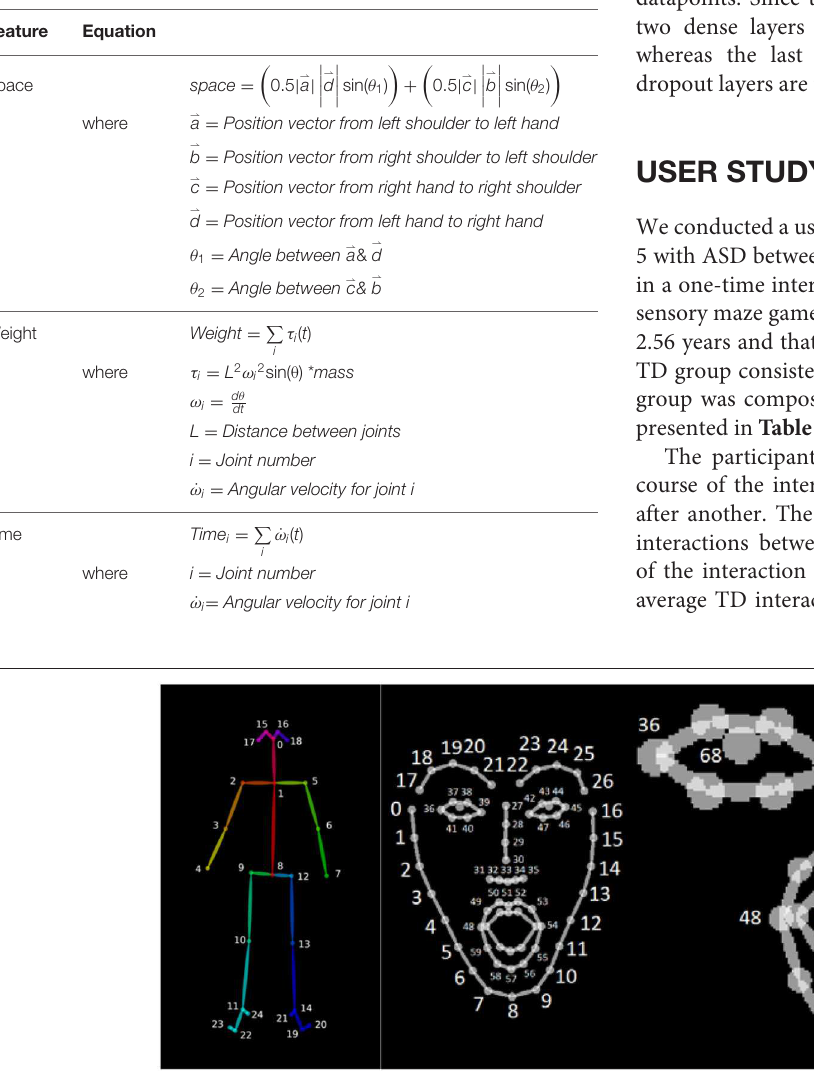
Frontiers in Robotics and AI |